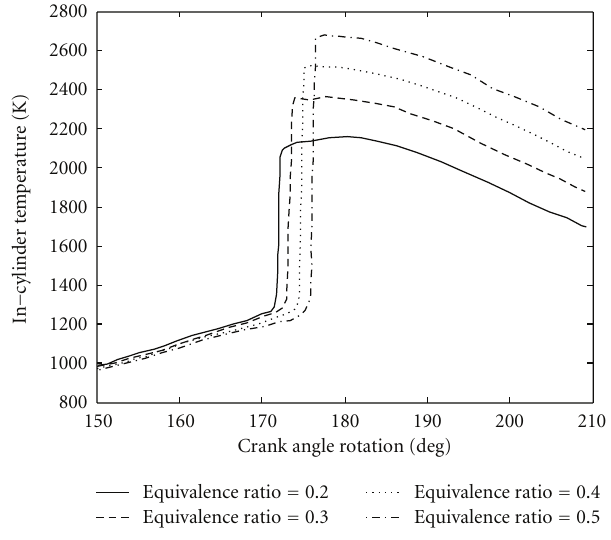
Figure 12: E ff ect of equivalence ratio variations on in-cylinder temperature.